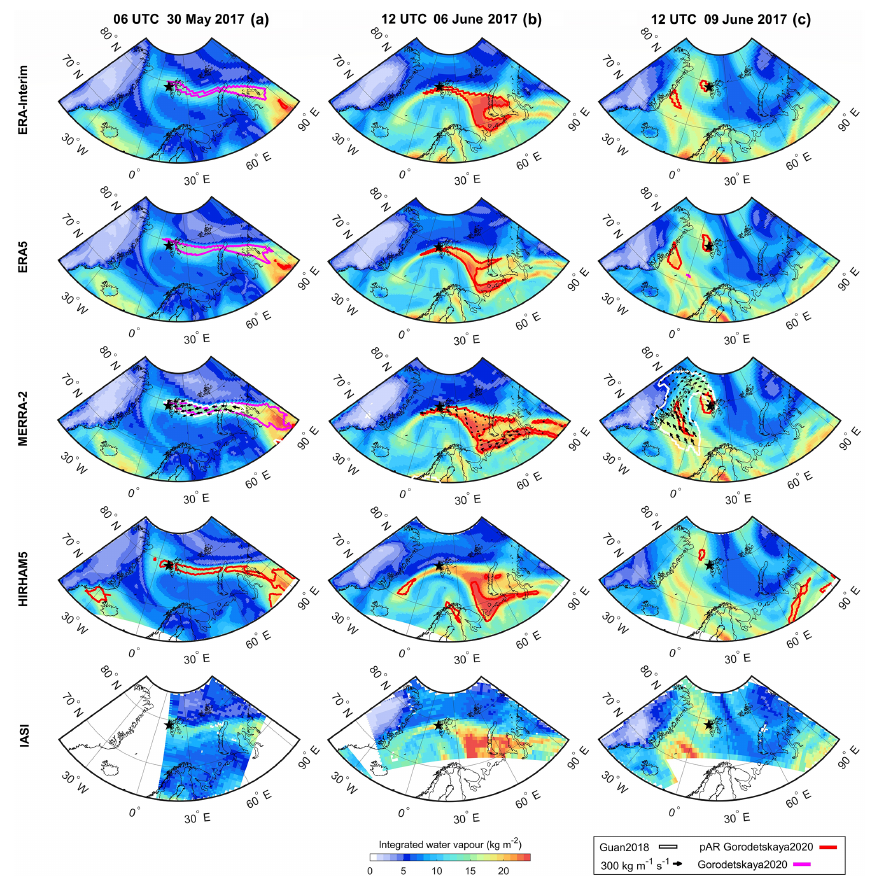
Figure 2. Maps of the integrated water vapour (IWV, kgm − 2 , coloured shading) for the times with the highest IWV values in Ny-Ålesund during the 30 May event (first column, a ), the 6 June event (second column, b ), and the 9 June event (third column, c ) based on reanalyses (ERA-Interim, ERA5, and MERRA-2), the HIRHAM5 model, and IASI observations. The magenta line shows the AR shape (based on Gorodetskaya2020), and the red line shows the shape of pARs (IWV ≥ IWV thres , based on Gorodetskaya2020). The white line shows the AR shape (based on Guan2018), and black arrows show the integrated vapour transport (IVT, kgm − 1 s − 1 ), both based only on MERRA-2 reanalysis. Note that the AR shape based on Gorodetskaya2020 might overlap with the pAR shape in some cases. The black star shows the Ny-Ålesund location. Figures S1, S2, and S3 show the complete temporal evolution of the events for all